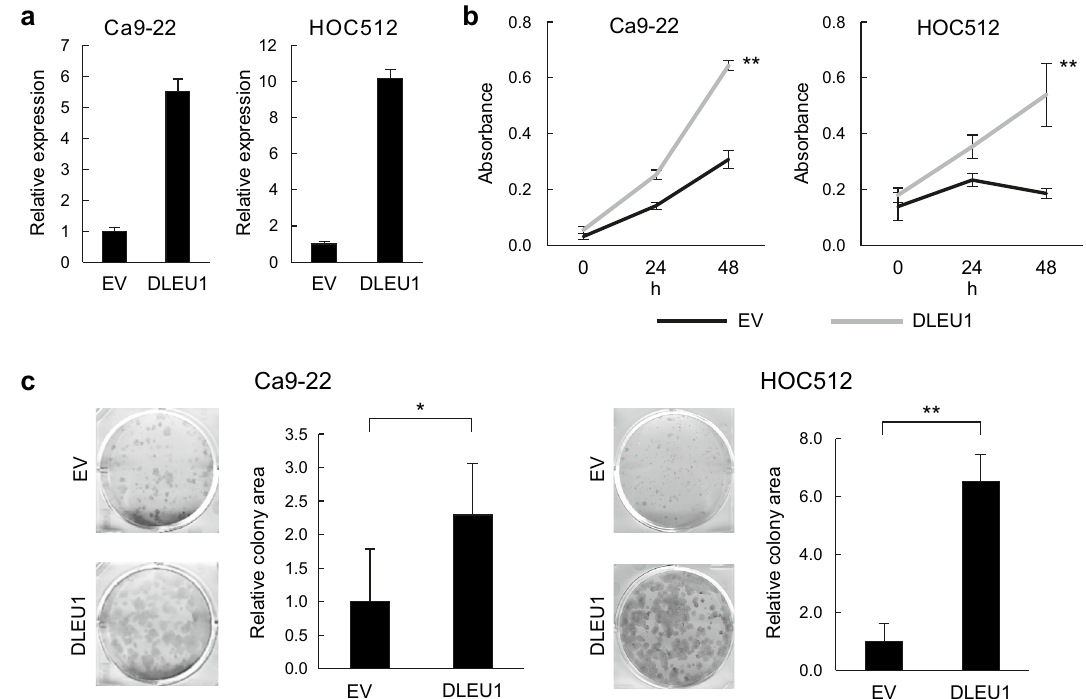
Figure 5. Effects of ectopic DLEU1 expression on OSCC cell proliferation. ( a ) qRT-PCR analysis of DLEU1 in OSCC cells infected with an empty lentivirus vector (EV) or a DLEU1 expression vector. ( b ) Results of cell viability assays in OSCC cells with the indicated lentivirus vectors. ( c ) Results of colony formation assay in OSCC cells infected with indicated lentivirus vectors. * P < 0.05, ** P <